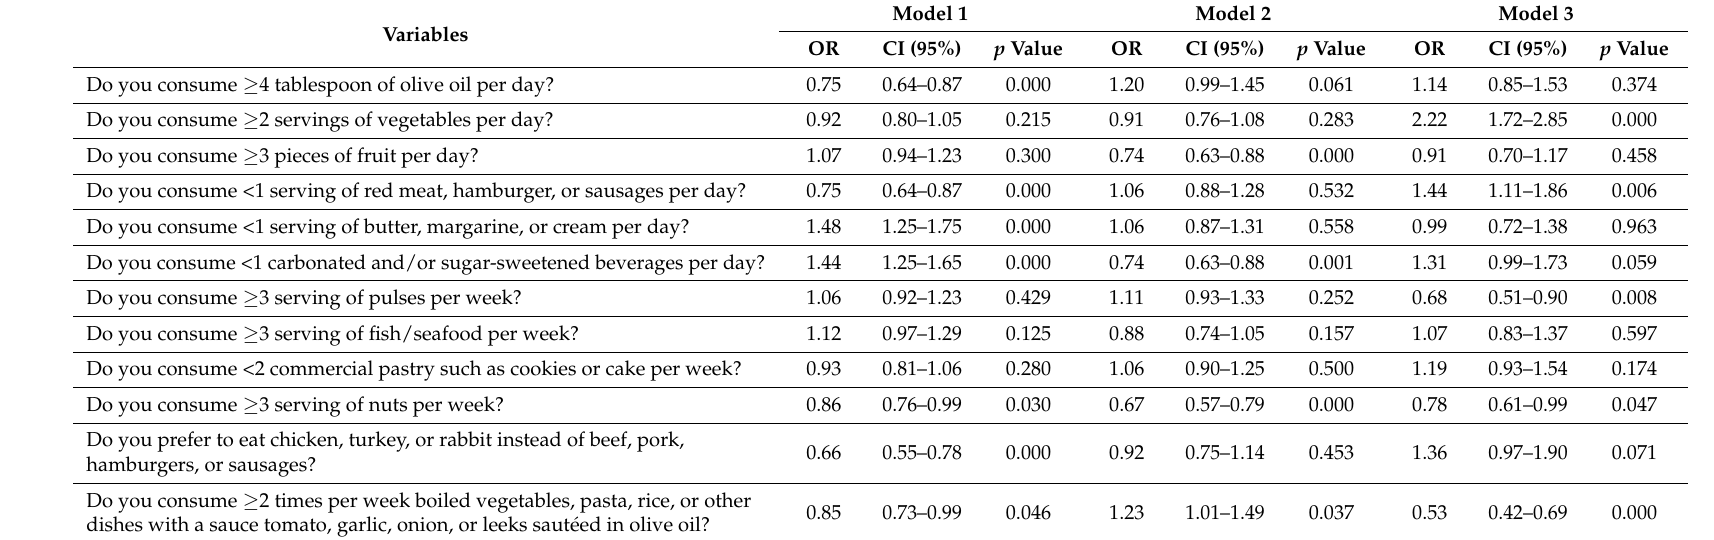
Table 2. Binary logistic regression for the different aspects of the Mediterranean